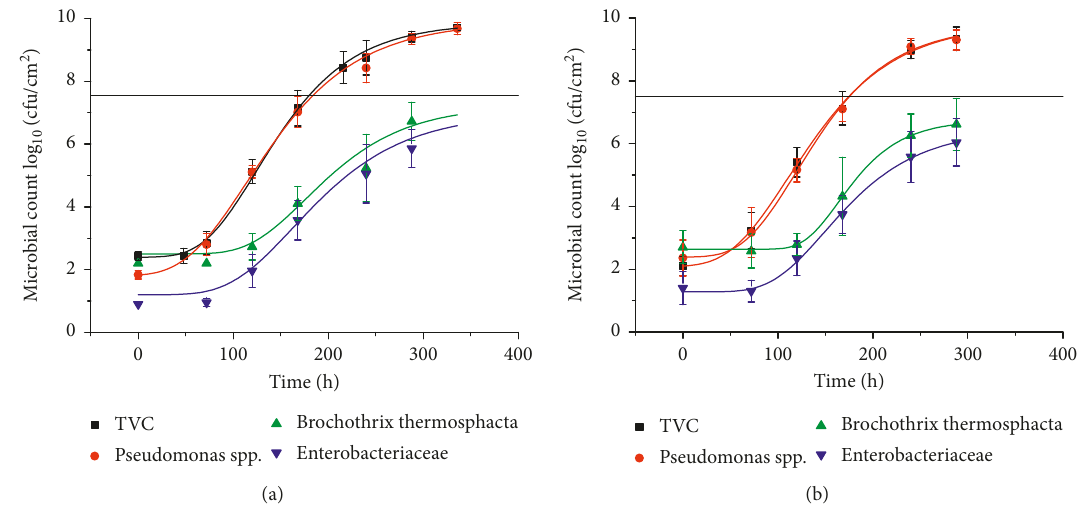
Bold parameters indicate differences between productions systems are significant at the 0.05 level.